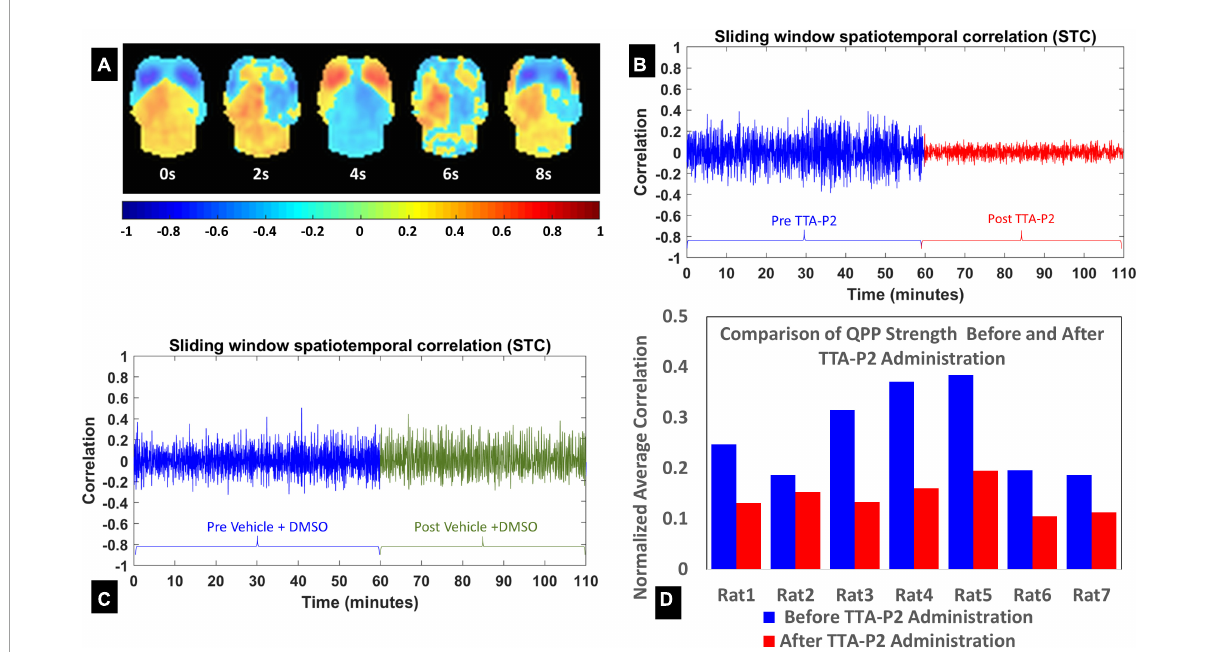
FIGURE1 (A) Eight frames from the quasi-periodic pattern (QPP) template obtained from both groups’ pre-injection concatenated functional time-series (window length = 10 s). (B,C) The evolution of the QPP strength with time assessed with spatiotemporal correlation of the fMRI time-series with corresponding QPP template on one rat (B) after systematic administration of TTA-P2; and one rat (C) after systematic administration of Vehicle. (D) The QPP strength changes for each rat in the TTA-P2 group. The values are estimated as the mean of positive excursions of the spatiotemporal correlation (STC) curve above zero, normalized by the maximum correlations for each subject.